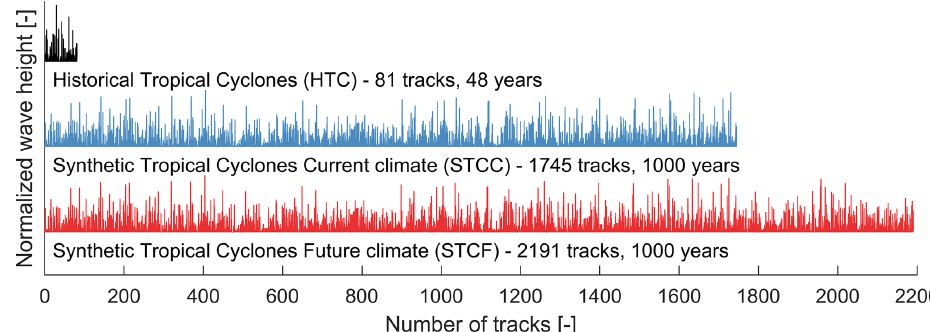
Figure 4. Normalized wave height and number of tracks for HTCs (black), STCC (blue) and STCF (red) at Charchenga,